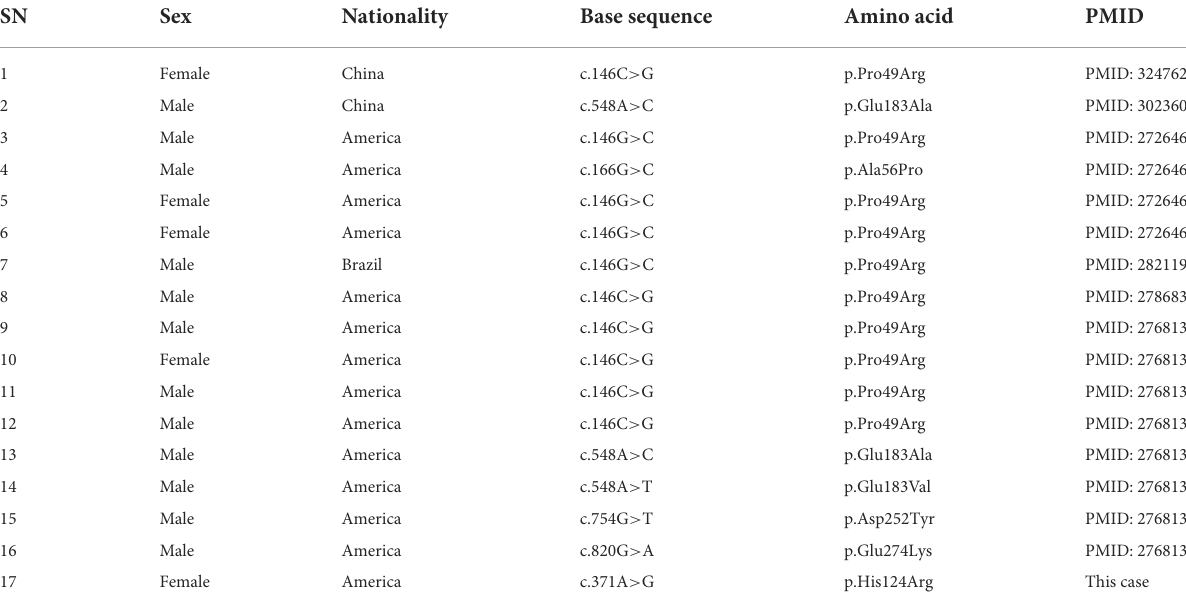
TABLE 1 Basic information of the 17 cases of NSLH2 caused by PPP1CB gene mutation reported in literature.